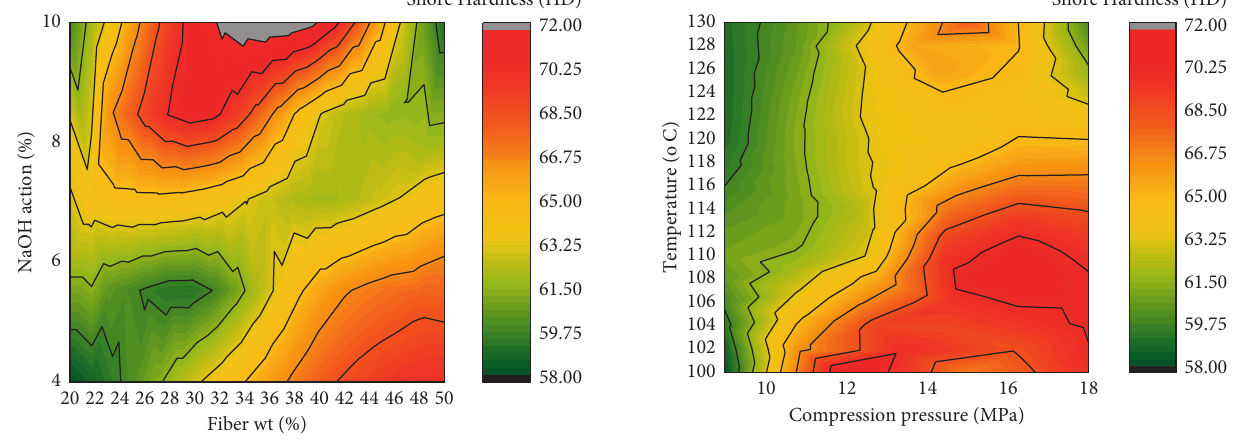
Figure 22: Shore D hardness: contour plot of fiber weight per- centage and NaOH action.